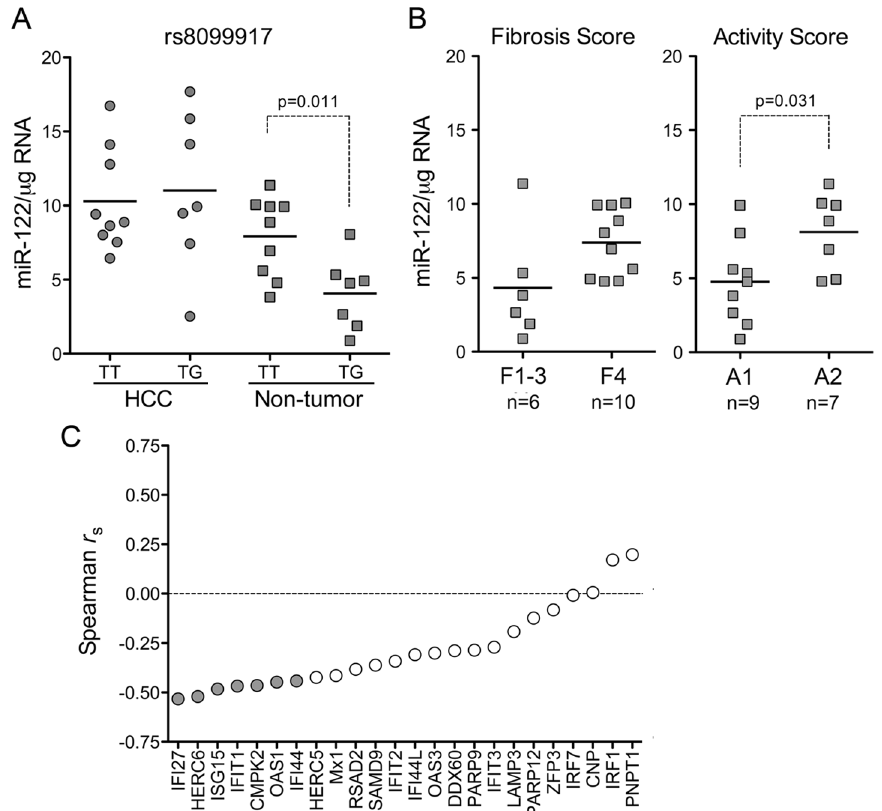
Figure 5. miR-122 expression, IL28B genotype, Metavir scores and ISG transcript levels in HCV-infected human liver. ( A ) miR-122 expression in HCC and paired non-tumor samples from subjects with HCV infection, grouped according to rs8099917 genotype (TT or GT). ( B ) miR-122 expression levels in non-tumor tissue from HCV-infected subjects categorized according to Metavir score for (left) fibrosis and (right) inflammatory activity. ( C ) Correlation between miR-122 abundance and expression levels of selected ISGs determined by Affymetrix U133 Plus 2.0 Array analysis. With the exception of OAS1 and Mx1, intrahepatic transcript levels of these ISGs have been shown previously to be predictive of Peg-IFN/RBV treatment outcome [31]. “r Spearman rank-order correlation coefficient. Filled symbols indicate a statistically significant negative correlation (p<0.05 by one- sided t